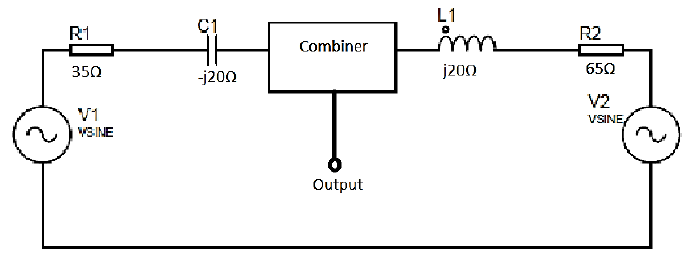
Figure 4. The equivalent circuit of the phased array affected by mutual coupling.